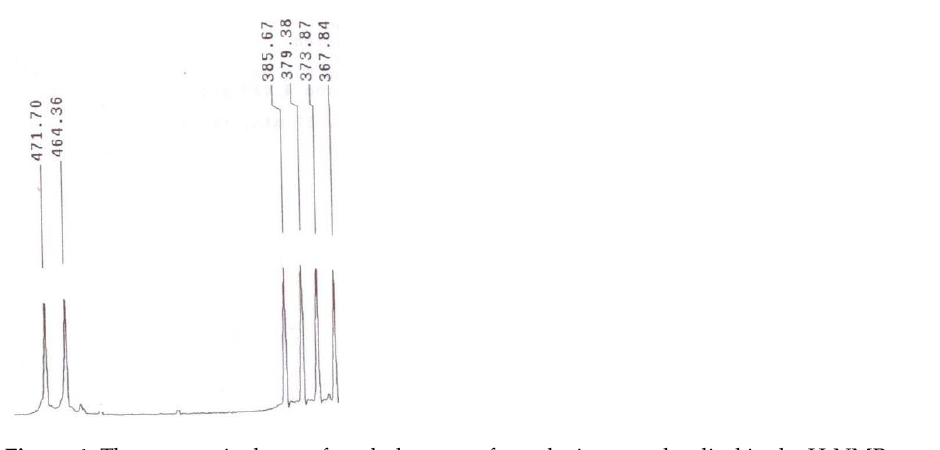
Figure 4. The non-equivalence of methyl protons from the isopropyl radical in the H-NMR spectra of esters 4 and 7 .